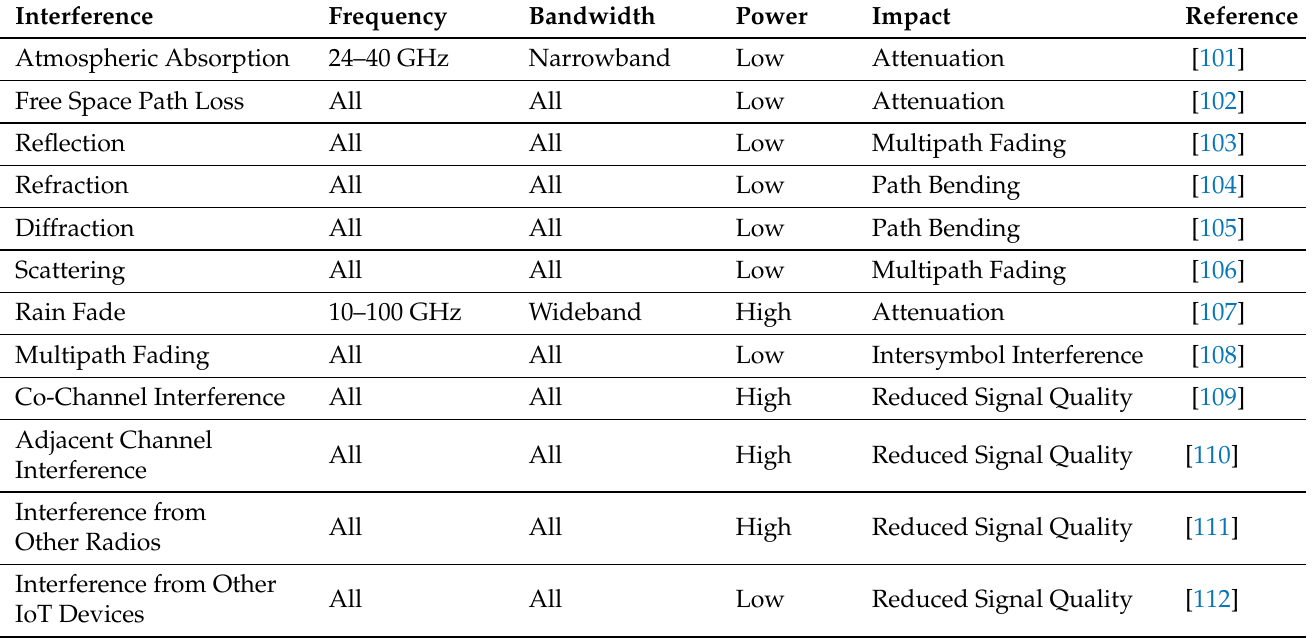
Table 13. Interference characteristics in 5G networks and IoT